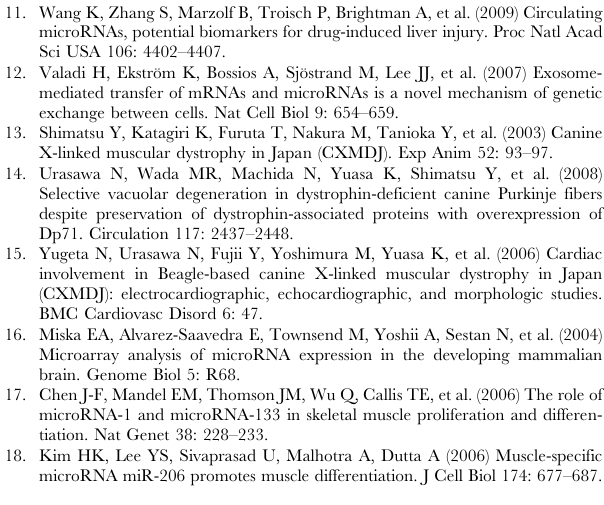
Figure S1 miRNA expression in 8-week old male wild- type control and mdx serum. Expression levels of miRNAs were determined by real-time PCR. Results are shown as relative expression, and data are presented as mean 6 SEM, n= 5.